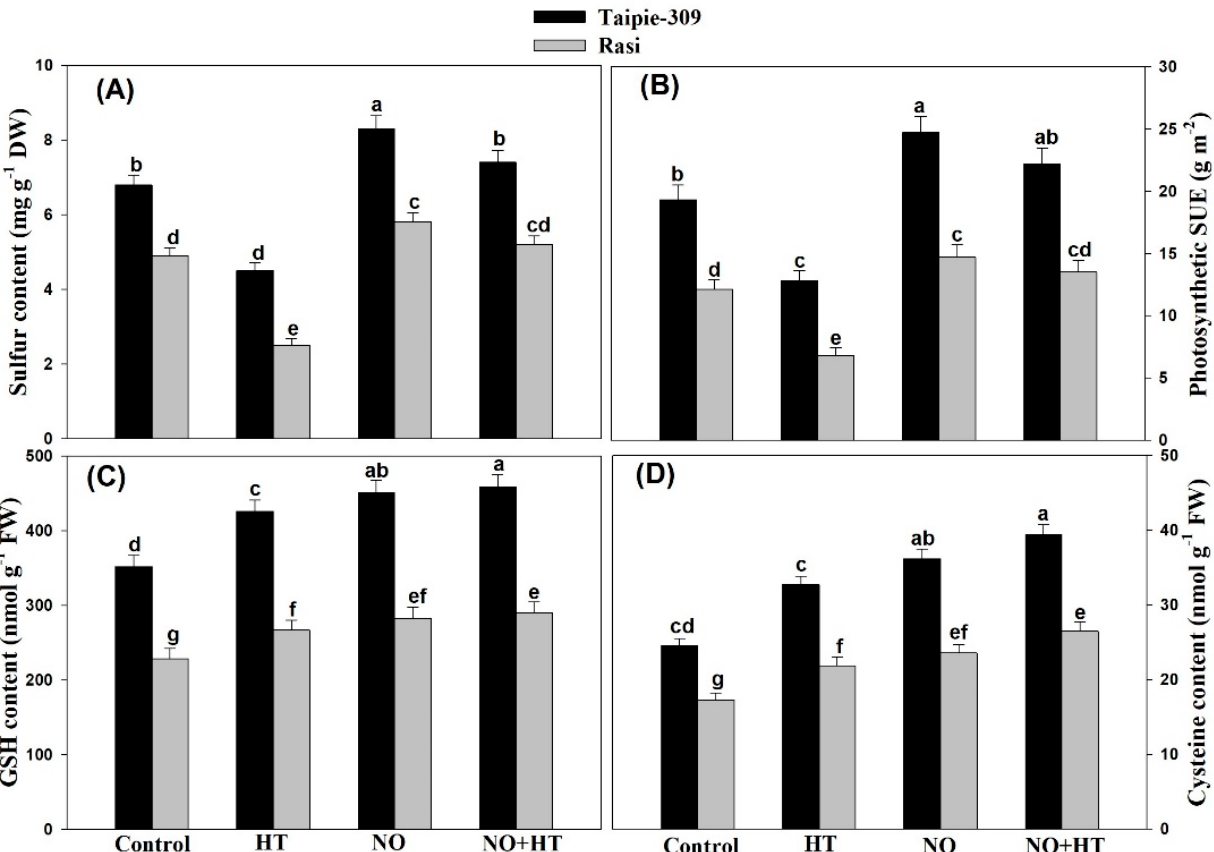
Figure 6. Leaf sulfur content ( A ), photosynthetic SUE ( B ), GSH content ( C ), and Cys content ( D ) in Taipie-309 and Rasi cultivars of rice ( Oryza sativa L.) at 30 days after germination (DAG), plants were grown with/without high temperature stress and treated with foliar 100 µ M SNP (NO donor). Data are presented as treatments mean ± SE (n = 4). The values followed by same letters above bars represent that data did not differ significantly by LSD test at p < 0.05. DW, dry weight; FW, fresh weight; SUE, sulfur use efficiency.